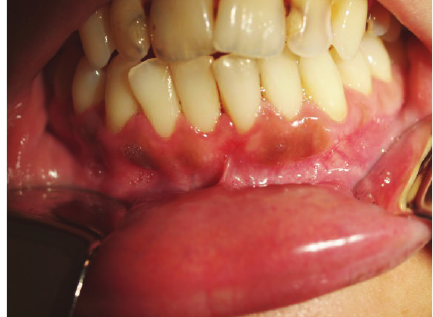
Figure 1: Initial clinical appearance with melanotic macules located on lower buccal gingiva.